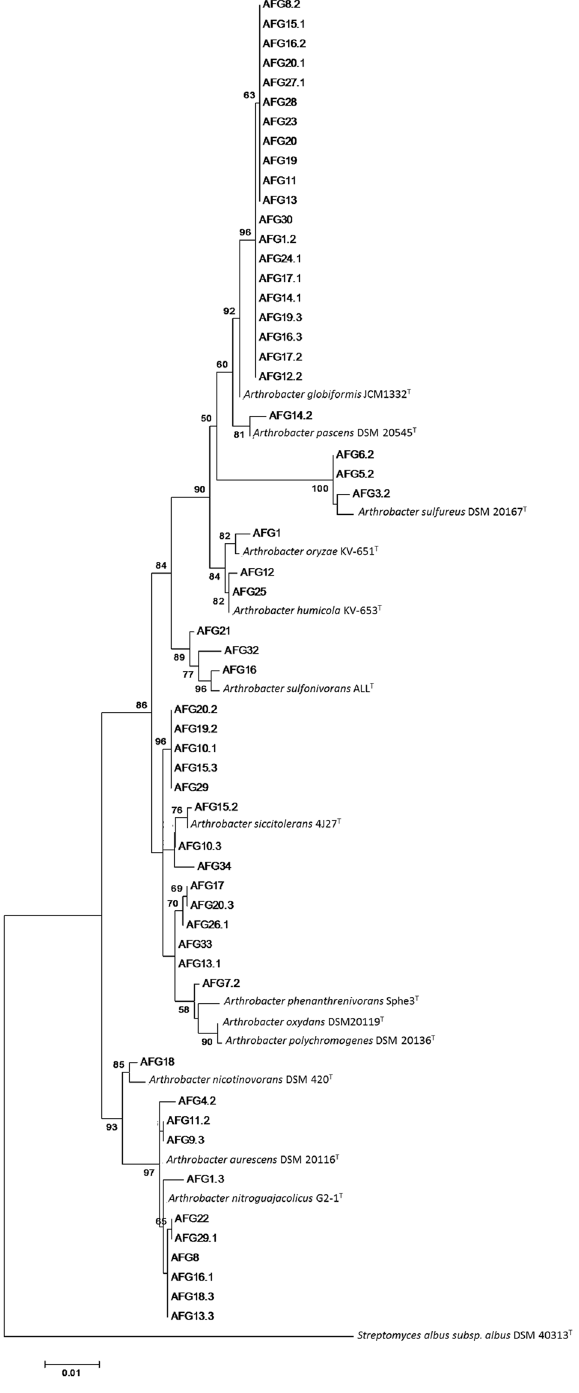
Figure 3. Maximum likelihood phylogenetic tree based on 16S rRNA gene sequences showing the relationship between the 55 isolated Arthrobacter strains and the closest recognized Arthrobacter species. Bar, 0.01 substitutions per nucleotide position. Bootstrap percentages (1000 replicates) above 50% are shown at